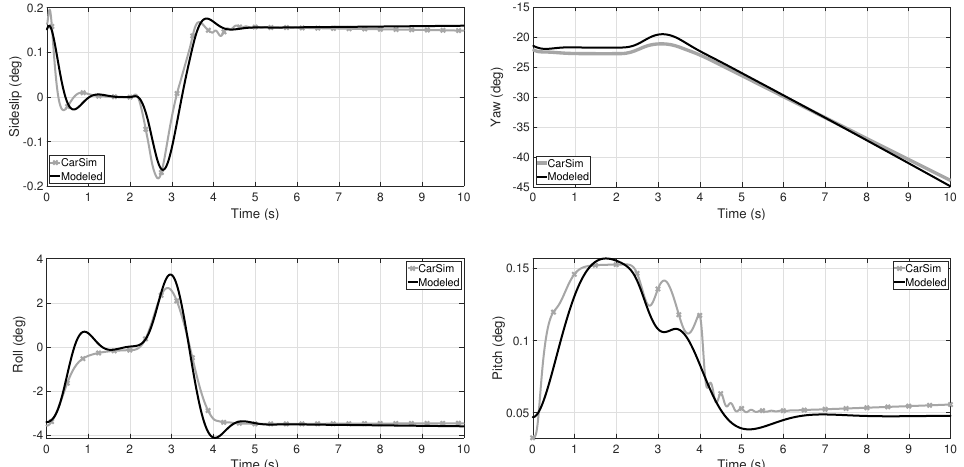
Figure 3. Comparison of the TWV side slip and Euler’s angles, calculated by means of the presented model and those provided by CarSim. In average, the error is minimal and as expected; the model can not reproduce a highly non-linear behavior as small oscillations, for